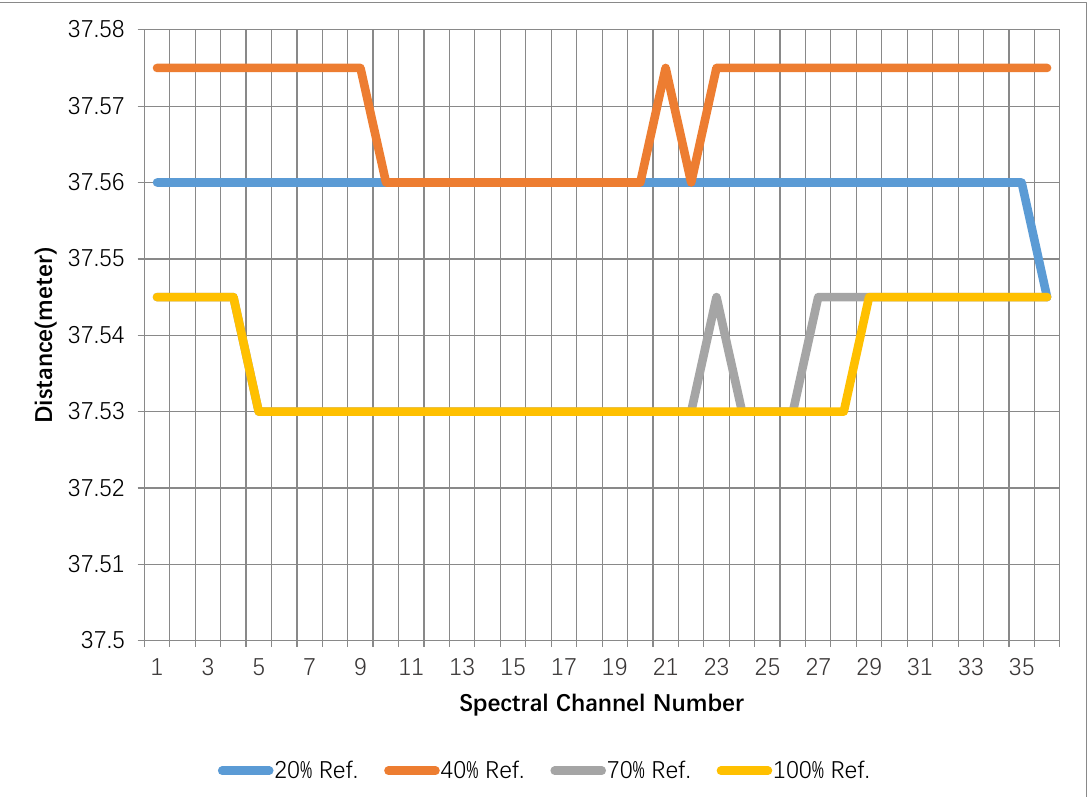
Figure 3. Range measurements of the AOTF-HSL from 650 nm to 1000 nm on 4 standard targets with different reflectivity.